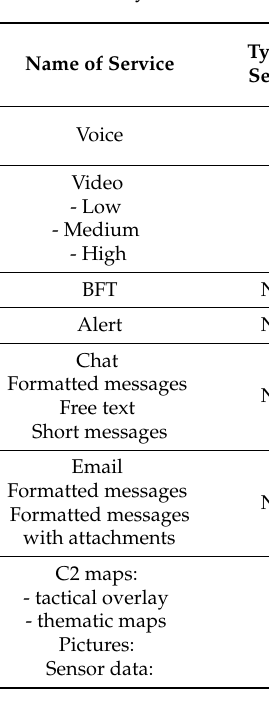
Table 1. Military MANET services